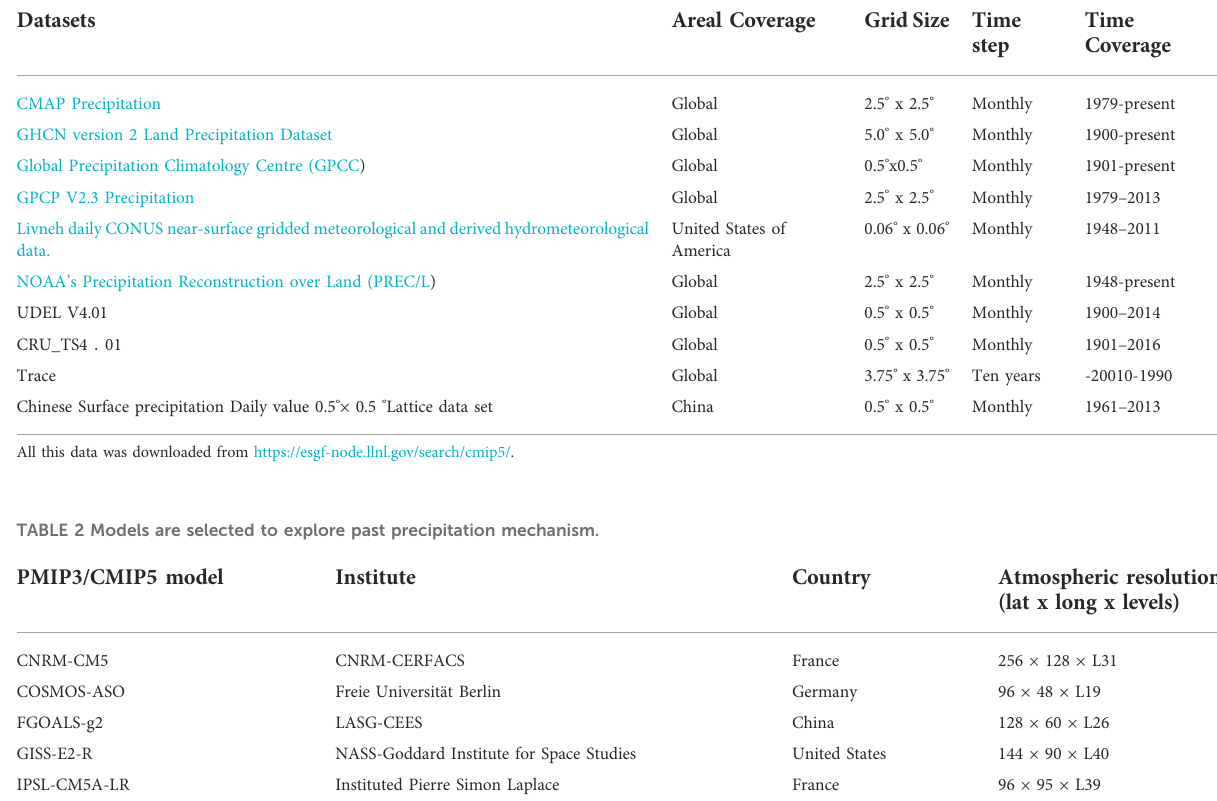
TABLE 1 Datasets are selected to analyze precipitation over the last